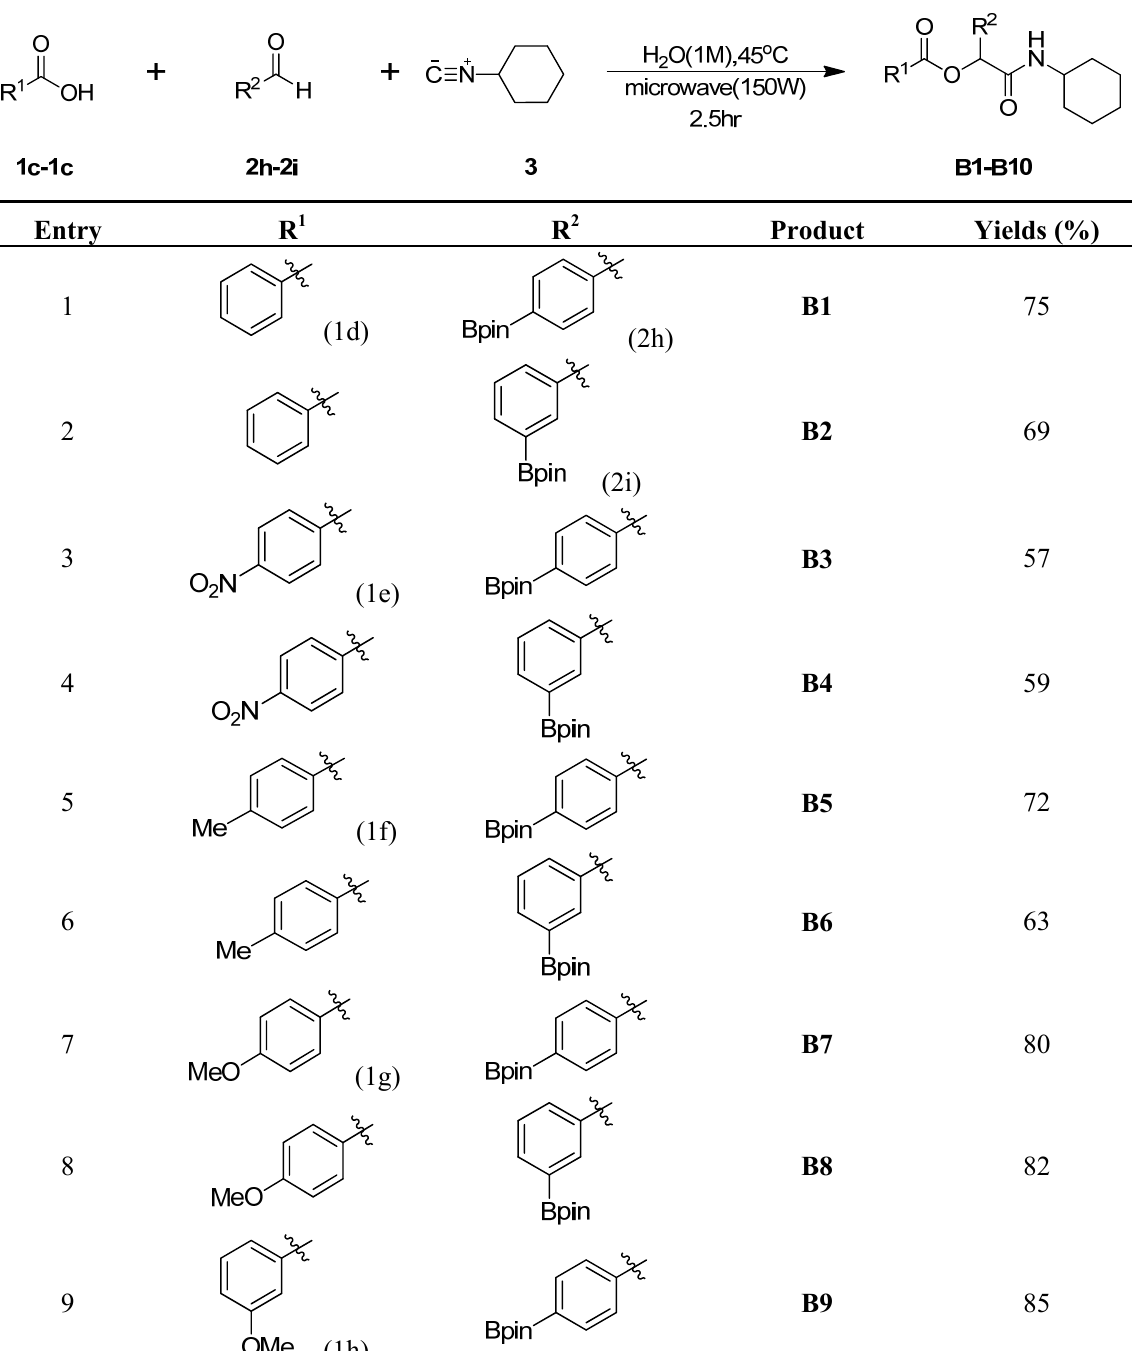
Table 4. Synthesis of Passerini products with boron containing aldehyde building